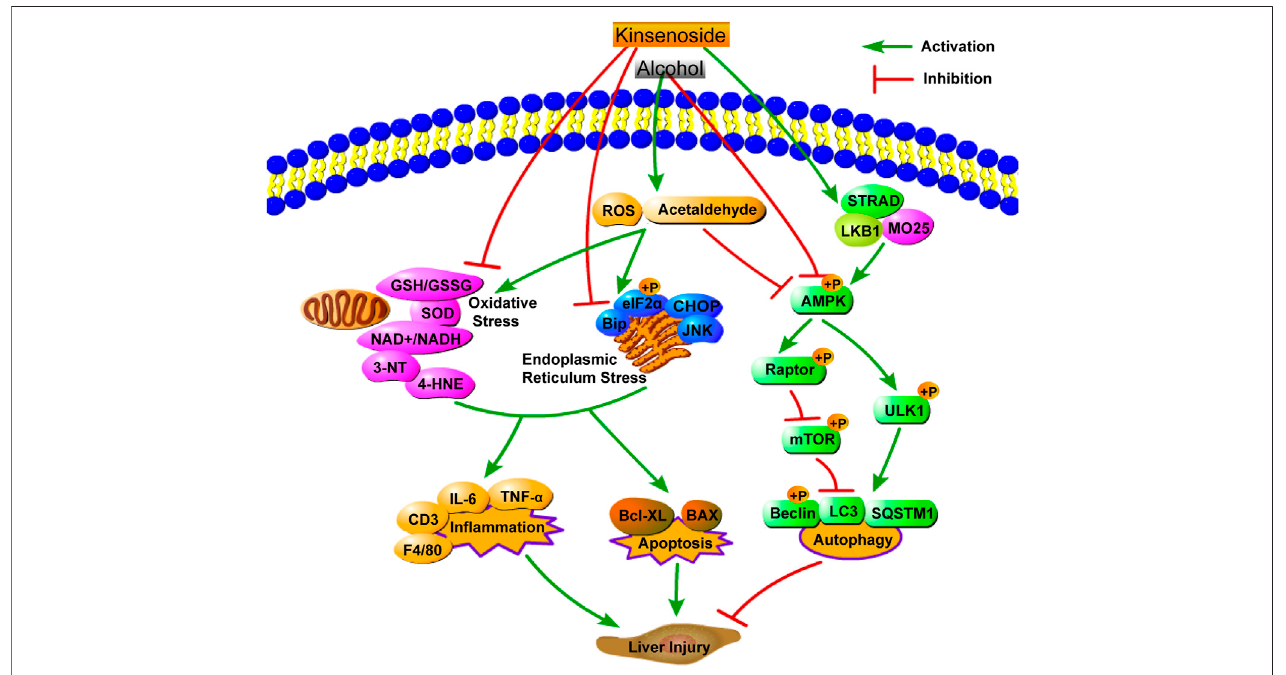
FIGURE 9 | A simpli fi ed diagram of the mechanism of KD on alcoholic liver